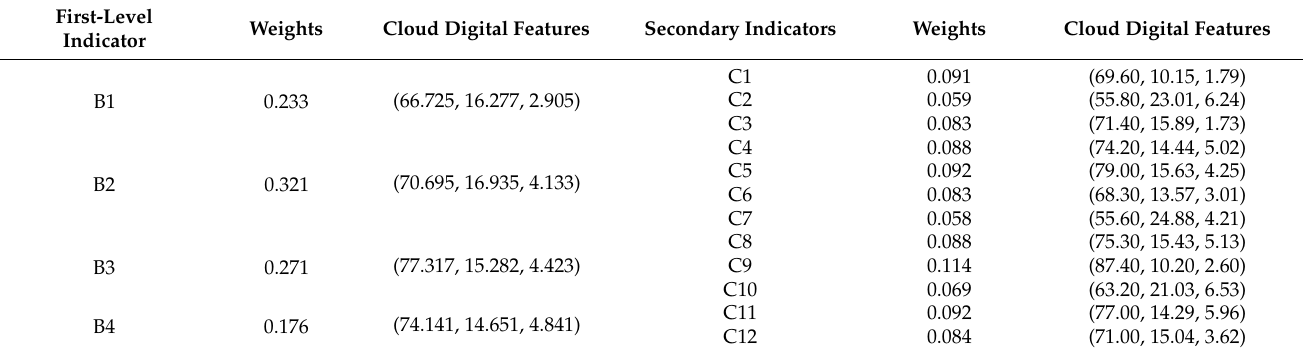
Table 5. Weights and cloud numerical feature results.